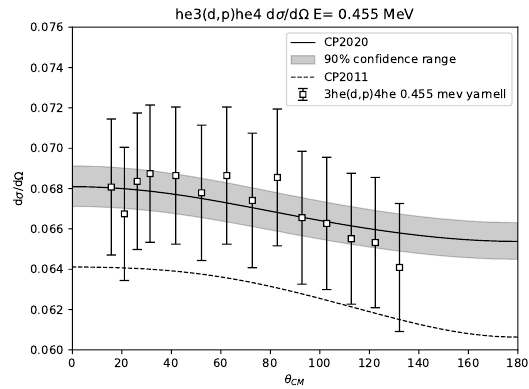
Figure 5. The angular distribution for 3 He( d , p ) 4 He for deuteron incident laboratory energy 455 keV of the unpolarized differential cross section in the center of mass as a function of the center of mass angle θ cm . The evaluation is shown by the solid curve. The gray band is the 90% confidence interval determined as described in the